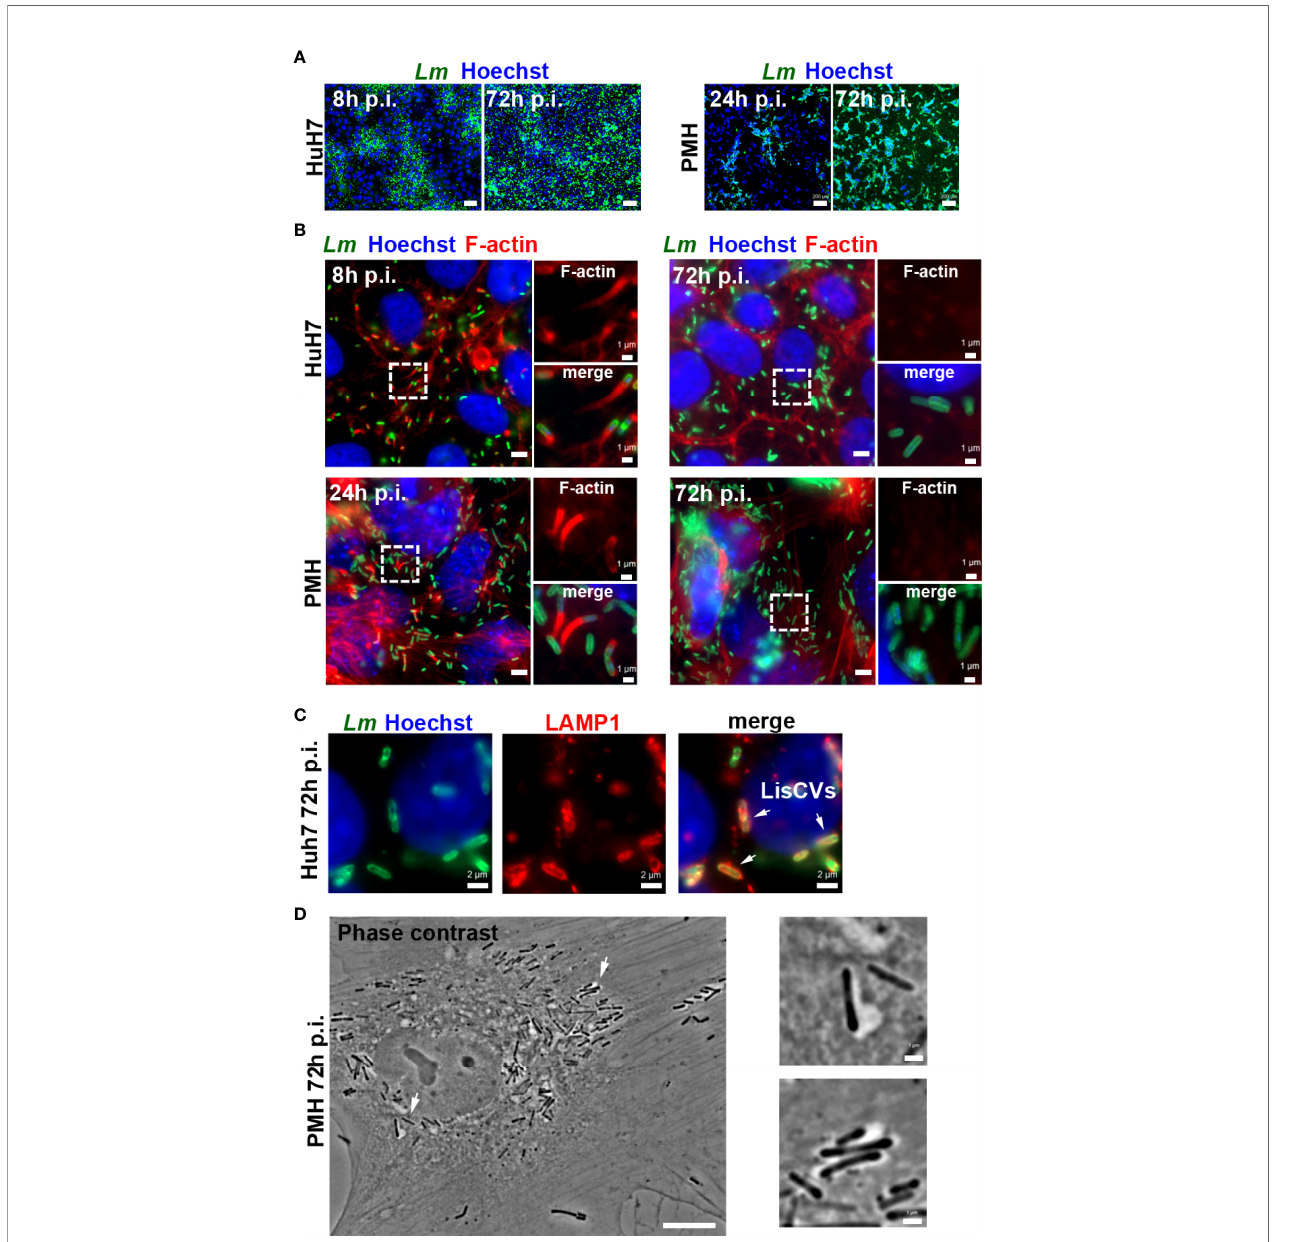
DC FIGURE 1 | Optimization of hepatocyte culture systems for modeling persistent Listeria infection. Different cell seeding conditions, MOI and Listeria strains (EGDe or 10403S) were tested to obtain optimal long-term Listeria infection of HepG2 (see Supplementary Figure S1 ), Huh7 or PMH. Infected cells were examined at day 1 (d1) and at day 3 (d3) by immuno fl uorescence microscopy: representative examples under optimized conditions are shown. (A) Low magni fi cation micrographs of Huh7 cells infected with EGDe strain (MOI=1-5) or PMH infected with 10403S strain (MOI=10) for the indicated time. Images are overlays of Listeria (green) and Hoechst (blue) signals (bars: 50 m m, Huh7, or 200 m m, PMH). (B) High magni fi cation micrographs of infected Huh7 or PMH showing Listeria (green), F-actin (red) and Hoechst (blue) signals. Bars: 5 m m. Boxed regions enlarged on the right show F-actin (top) or merged signals (bottom), highlighting actin-positive bacteria at d1 and actin-negative bacteria at d3 (bars: 1 m m). (C) Micrographs of an infected Huh7 cell at d3, showing Listeria (green), LAMP1 (red) and Hoechst (blue) signals. Arrows indicate 3 examples of LisCVs. (D) Phase contrast image of an infected PMH at d3 (bars: 10 m m). Arrows indicate 2 examples of bacteria within vacuoles, shown at a higher magni fi cation on the right (bars: 1 m